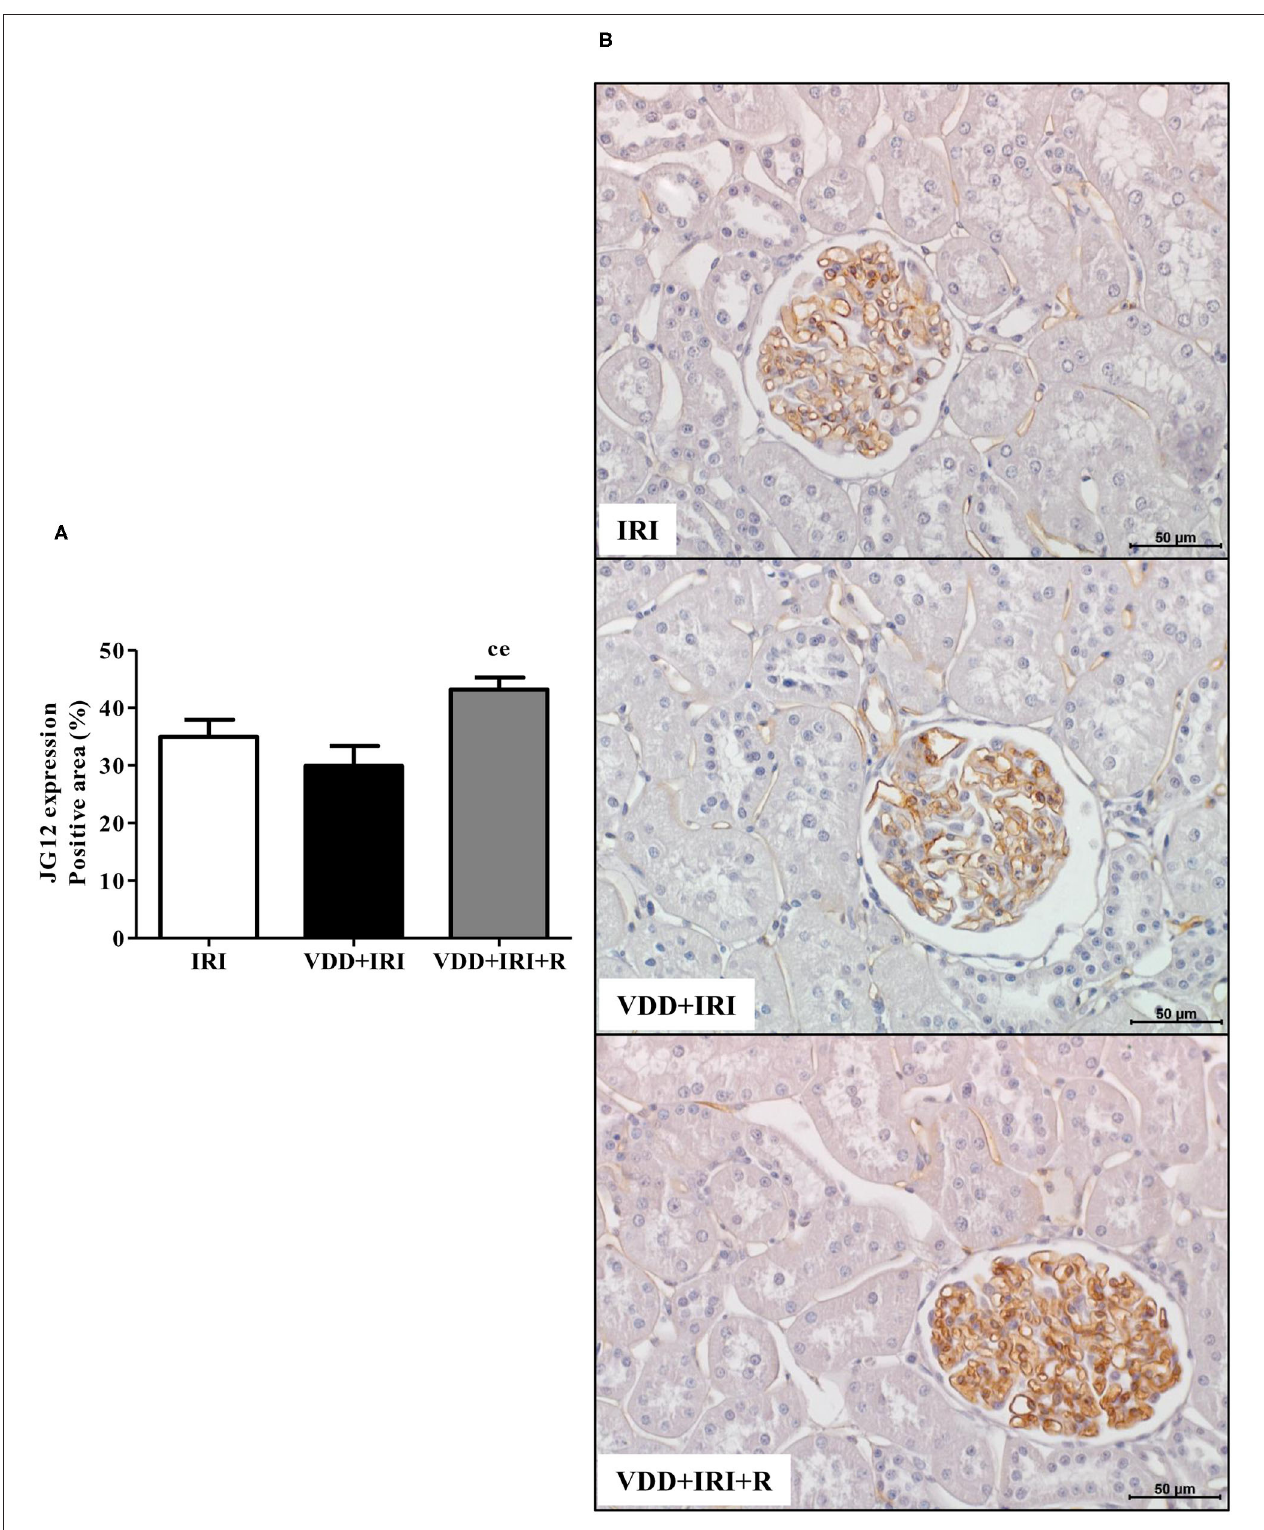
FIGURE 10 | Immunohistochemical analysis for aminopeptidase P (JG12) expression in the kidney tissue evaluated 90 days after ischemia/reperfusion insult (IRI) on day 30. (A) Bar graph of JG12 expression values. (B) Representative photomicrographs of immunostaining for JG12 in the renal cortex from an IRI, VDD + IRI and VDD + IRI + R rat ( × 400). Note that the restauration of vitamin D levels ameliorated the expression of JG12 in the VDD + IRI + R rats. Data are mean ± SEM. c p < 0.05, vs. IRI; e p < 0.01 vs. VDD + IRI. VDD, vitamin D deficiency; R, vitamin D replacement. Diet protocol: IRI, standard diet for 120 days; VDD + IRI, vitamin D-free diet for 120 days; and VDD + IRI + R, vitamin D-free diet in the first 30 days and standard diet in the last 90 days.